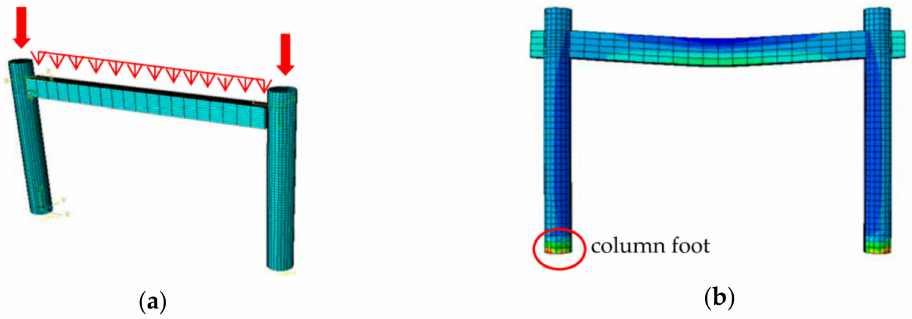
Figure 14. Lounge framework FEM (finite element method) model: ( a ) Loading model; ( b ) The von Mises stress contour plot.